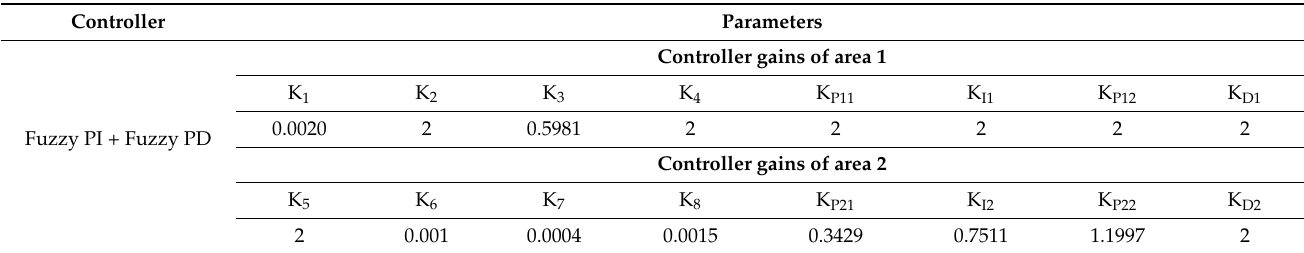
Table 9. The optimum Fuzzy PI + Fuzzy PD gains optimized by